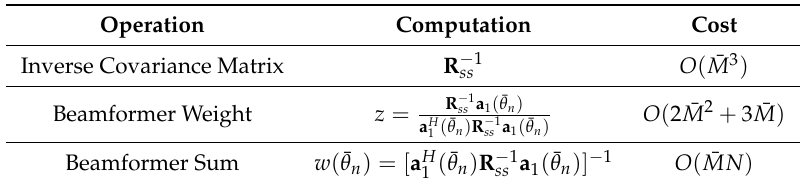
Table 1. Computational complexity of the minimum variance distortionless response (MVDR) algorithm. Operation